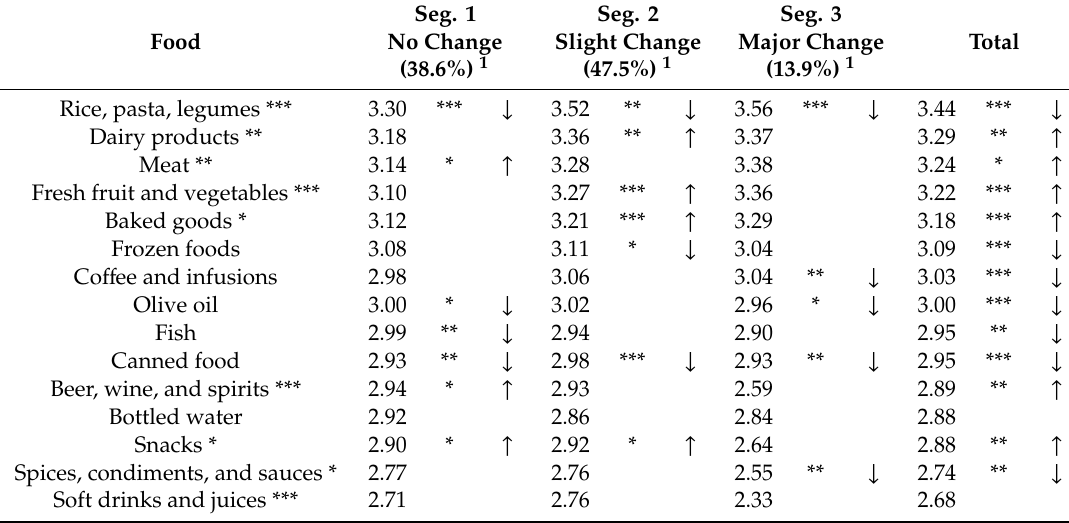
Canned food 2.93 Bottled